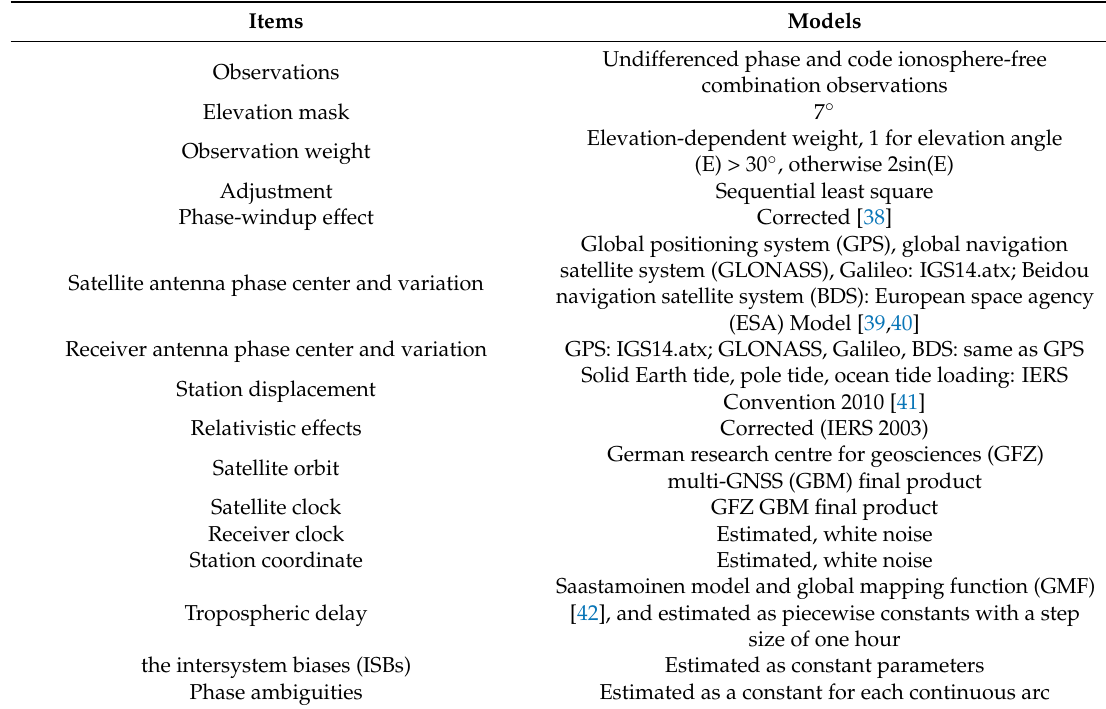
Table 1. The processing strategy and error model in the multiple global navigation satellite systems (multi-GNSS) combined